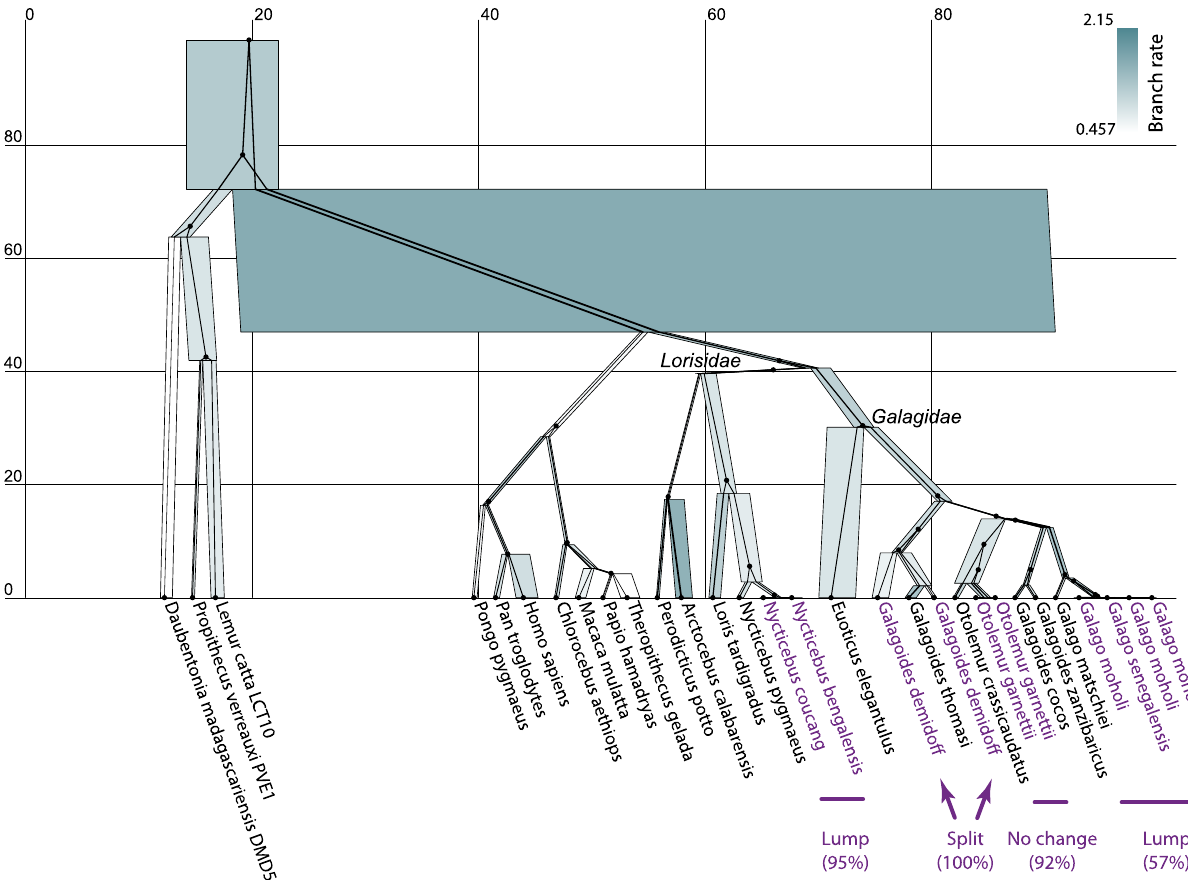
Fig. 5 Maximum a posteriori species tree of the primate dataset 35 . One arbitrarily selected gene tree (ADORA3) is displayed within the species tree. Node heights are in units of millions of years. Species tree node widths denote effective population sizes, and are coloured by relative branch substitution rates under a relaxed clock model. The posterior support (for ϵ = 10 − 2 ) of the four lump/split/no-change events are displayed. The analysis was performed using StarBeast3 27 and the fi gure was generated using UglyTrees 49